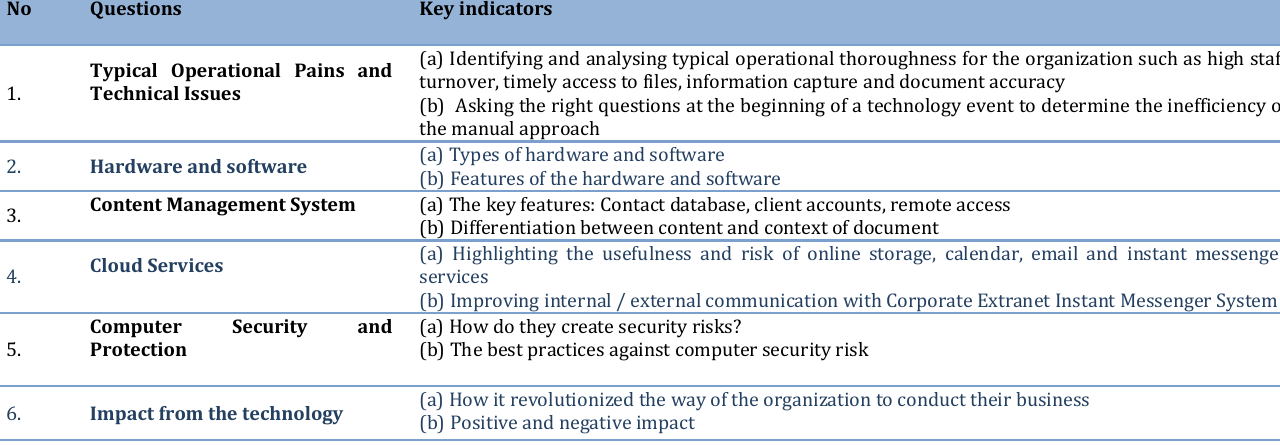
Table 2: Interview